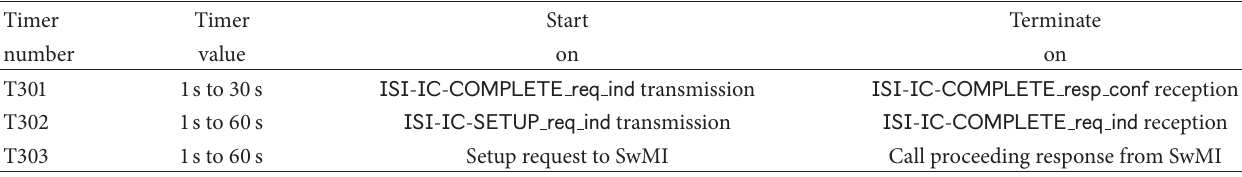
Table 1: TETRA protocol timer ranges [6].